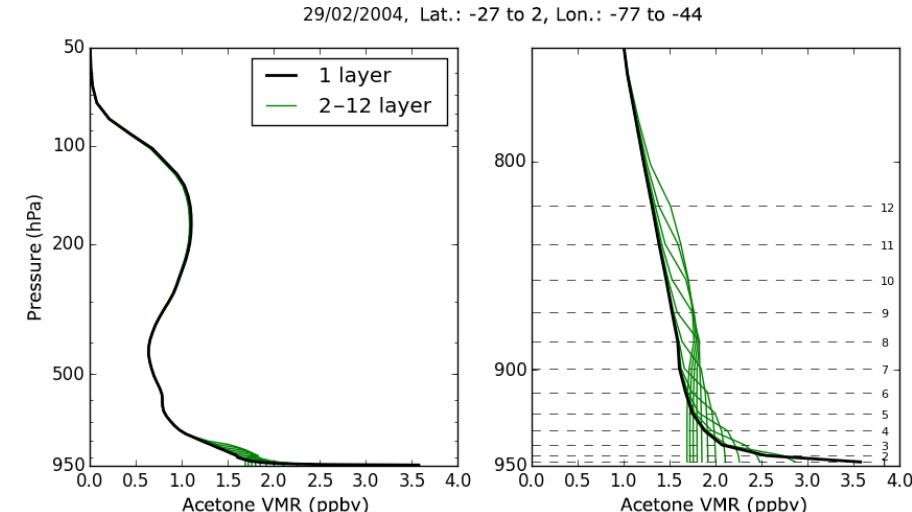
Figure 5. Profiles of the acetone VMR for n lev , emi = 1 (emission height of 20m above ground, black thick) and 2 to 12 (emission height of 65 to ∼ 1500m above ground, green thin lines) spatially averaged over the Amazon region in Brazil on 29 February 2004, about two months after initialisation. In the right panel, the pressure range is reduced and the average height of the 12 lowest model layers are illustrated by the dashed horizontal lines. Table 3. Technical details of the emission inventories from ECCAD for tracers in ICON-ART. For abbreviations of the emission types, see Table 2. Inventory Type Time range